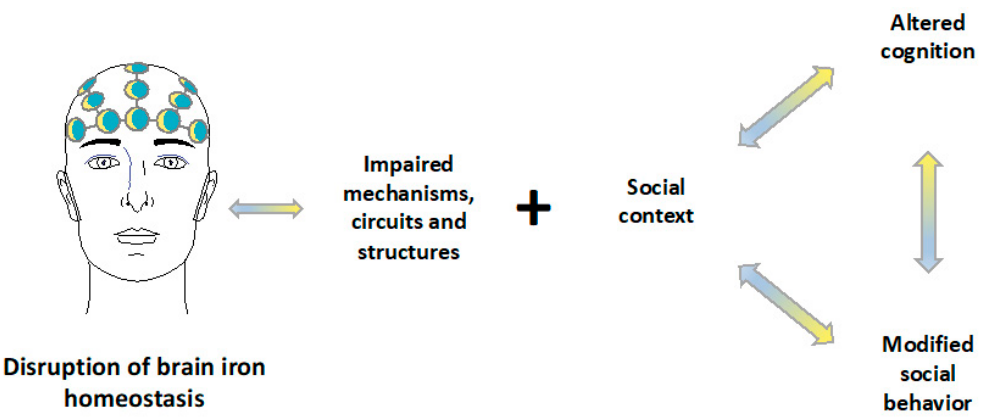
Figure 2. Impacts of disruption of brain iron homeostasis. Dysregulation of brain iron metabolism profoundly affects neurophysiological mechanisms (e.g., neurotransmitter synthesis and metabolism, axon myelination, neural transmission), neural circuits (e.g., mesocortical, mesolimbic, nigrostriatal, and tuberohypophyseal dopaminergic pathways) and brain structures. In the presence of a social context that does not provide stimuli to promote regular cognition and normative social behavior, disruption of brain iron homeostasis is associated with altered cognition (e.g., executive function, attention, memory) and modified social behavior (e.g., functional isolation, wariness, and hesitance